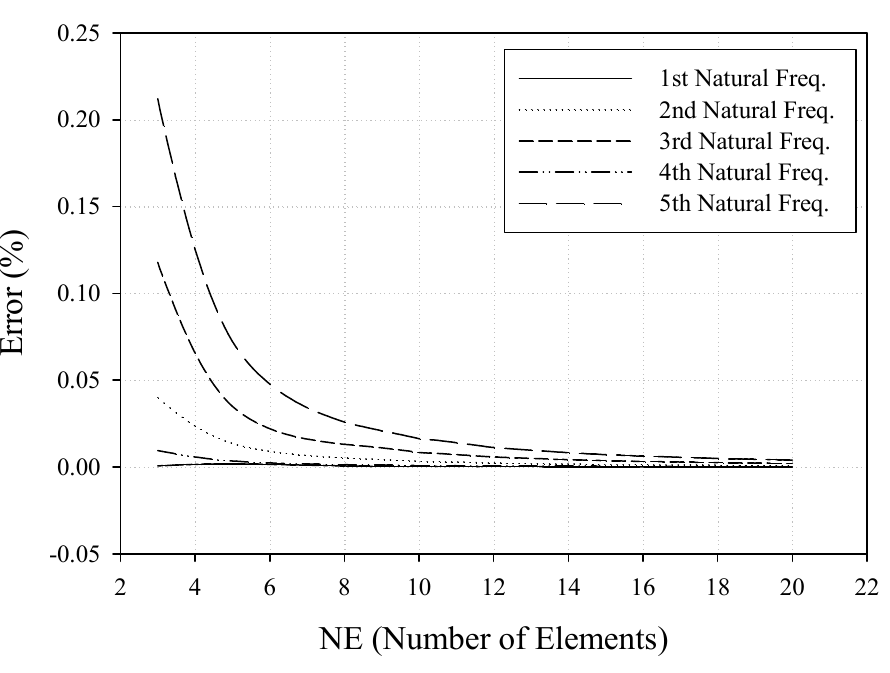
Figure 3. FEM error versus the number of elements for the first five natural frequencies. The percent error is relative to the exact values obtained from the DSM [12].